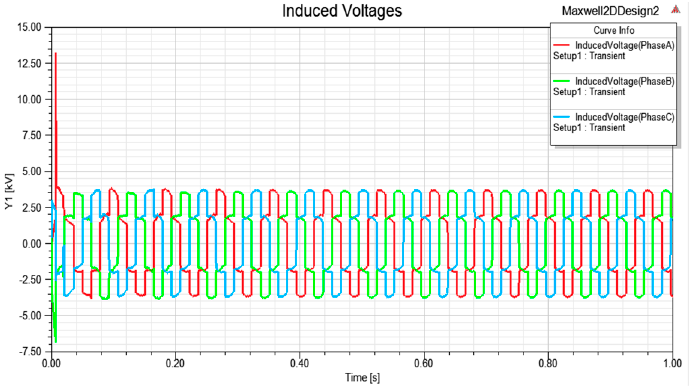
Figure 7. Curves for electromotive force in phases.